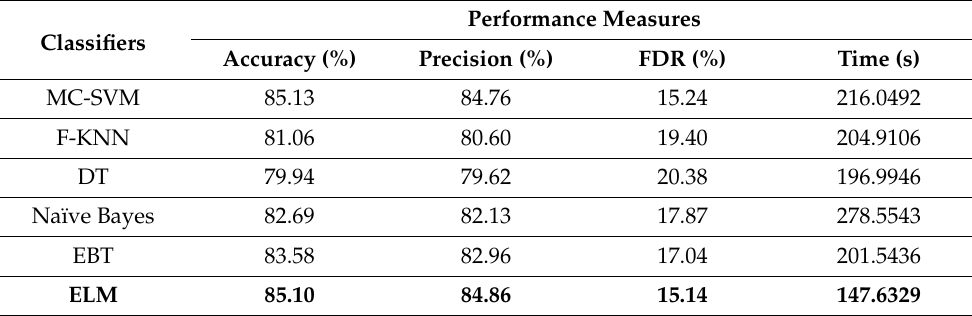
Table 2. Classification accuracy using HWOA based feature selection for HAM10000 dataset.